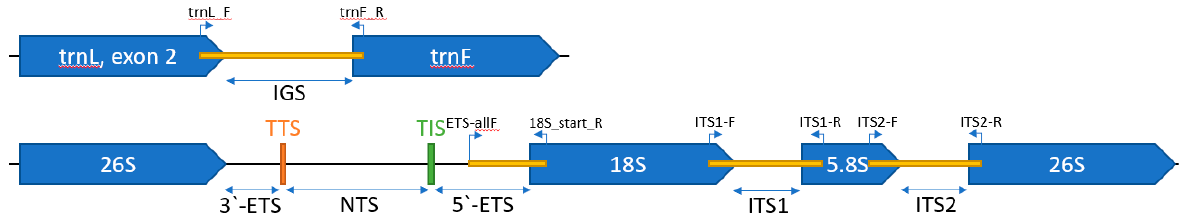
Figure 1. Primers’ binding sites scheme. IGS — intergenic spacer; NTS — non-transcribed part of rDNA; TIS — transcription initiation site; TTS — transcription termination site.